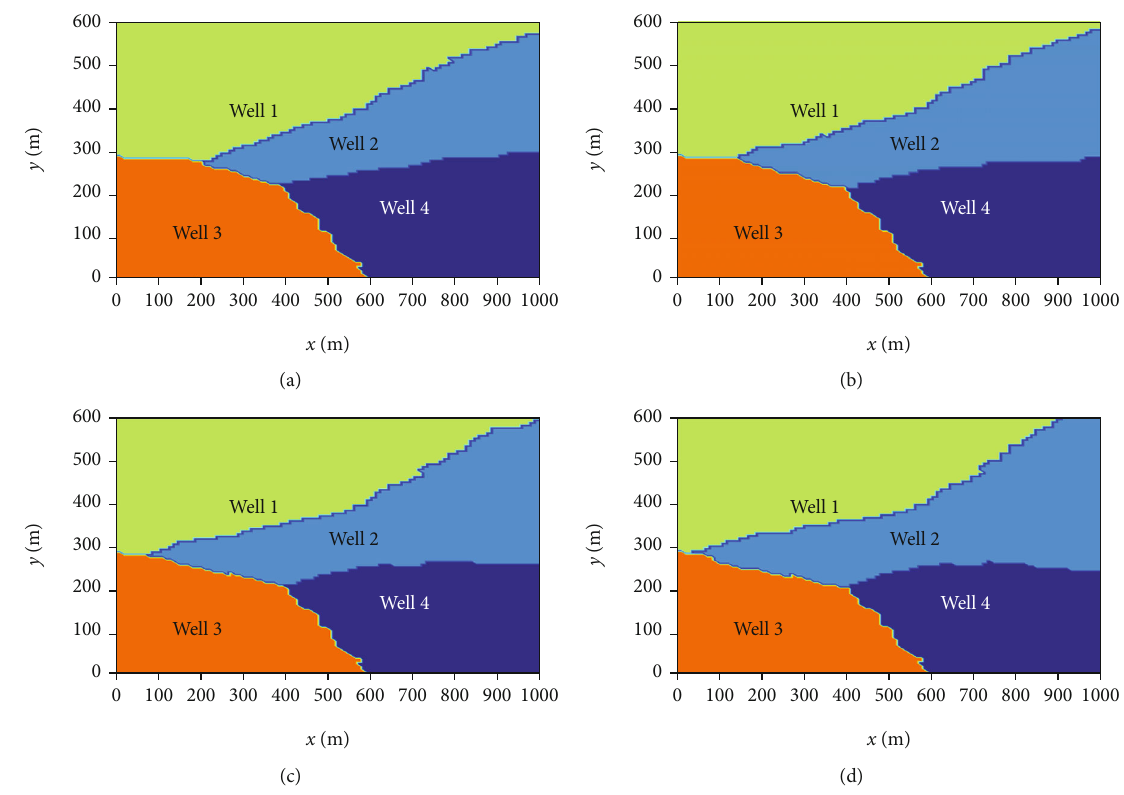
Figure 13: Geometries of the control volumes of the production wells with di ff erent fracture lengths of well 2.